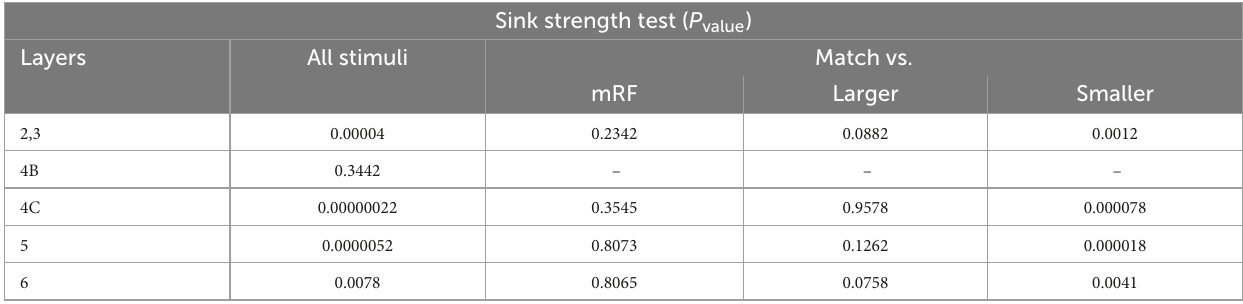
TABLE 5 The statistical test in each layer for sink strength